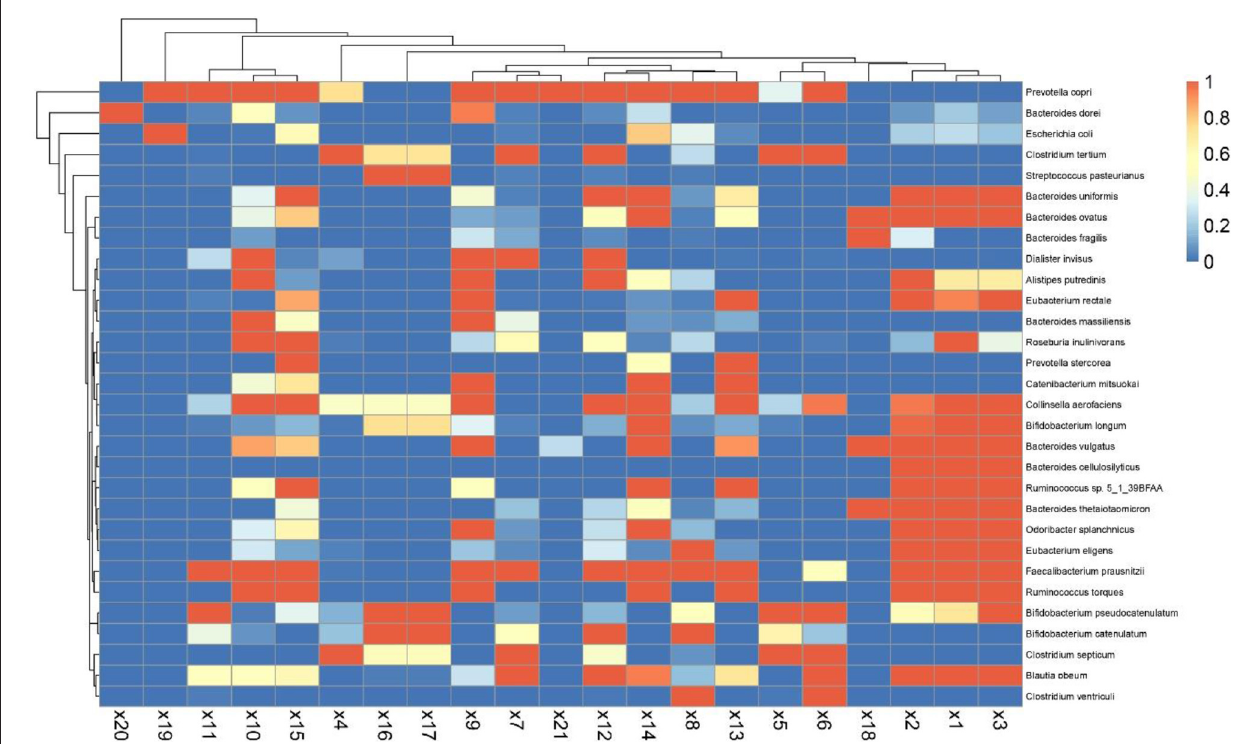
FIGURE 3 | Visualization of mean intestinal microbiota abundance in children with